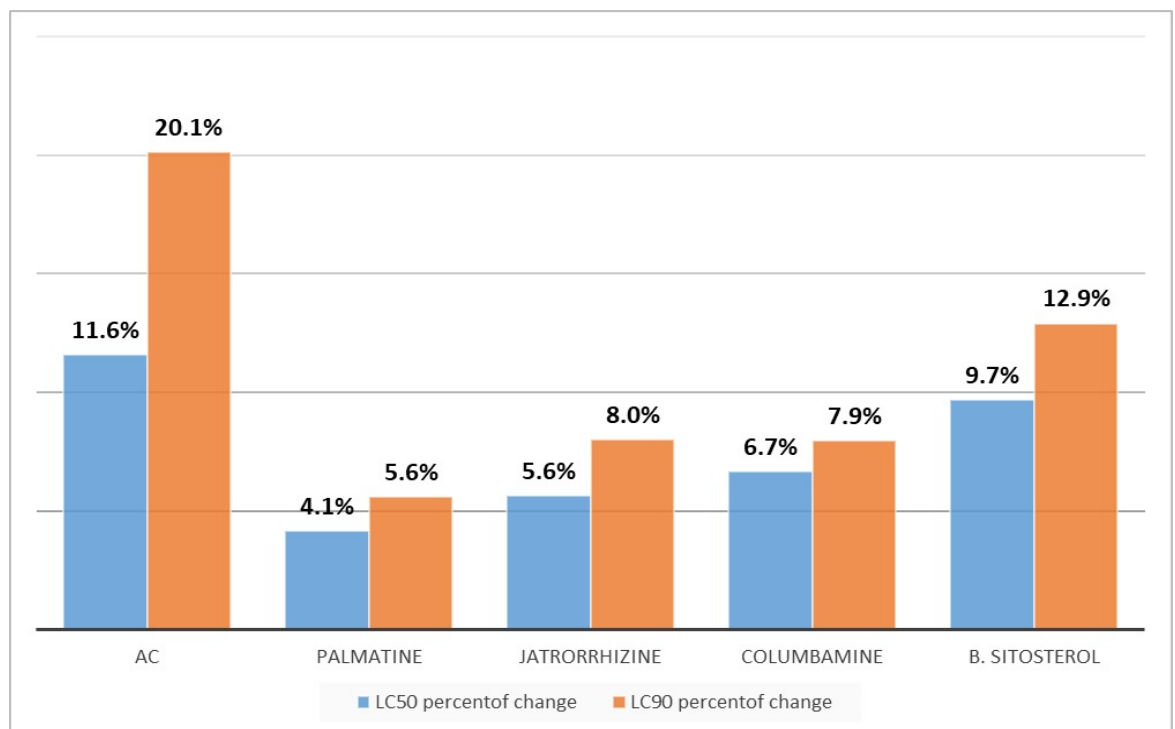
Figure 6. Comparison between lethal concentration values of palmatine, jatrorrhizine, columbamine, β -sitosterol, and Annickia chlorantha extract (AC) against mosquito larvae and the non-target model.